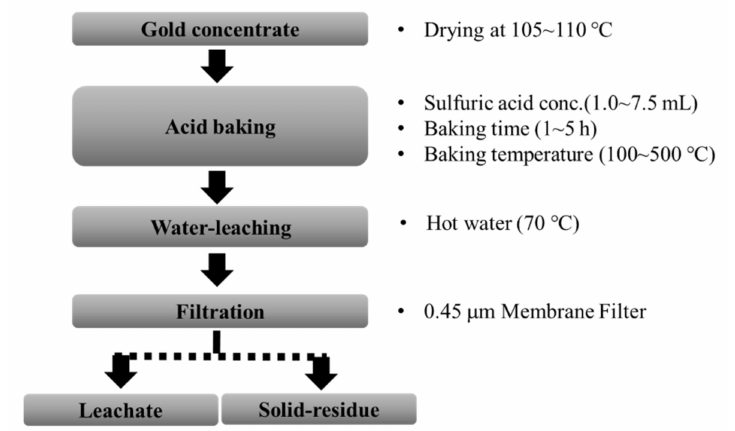
Figure 2. Flow sheet for the sulfuric acid baking-water leaching